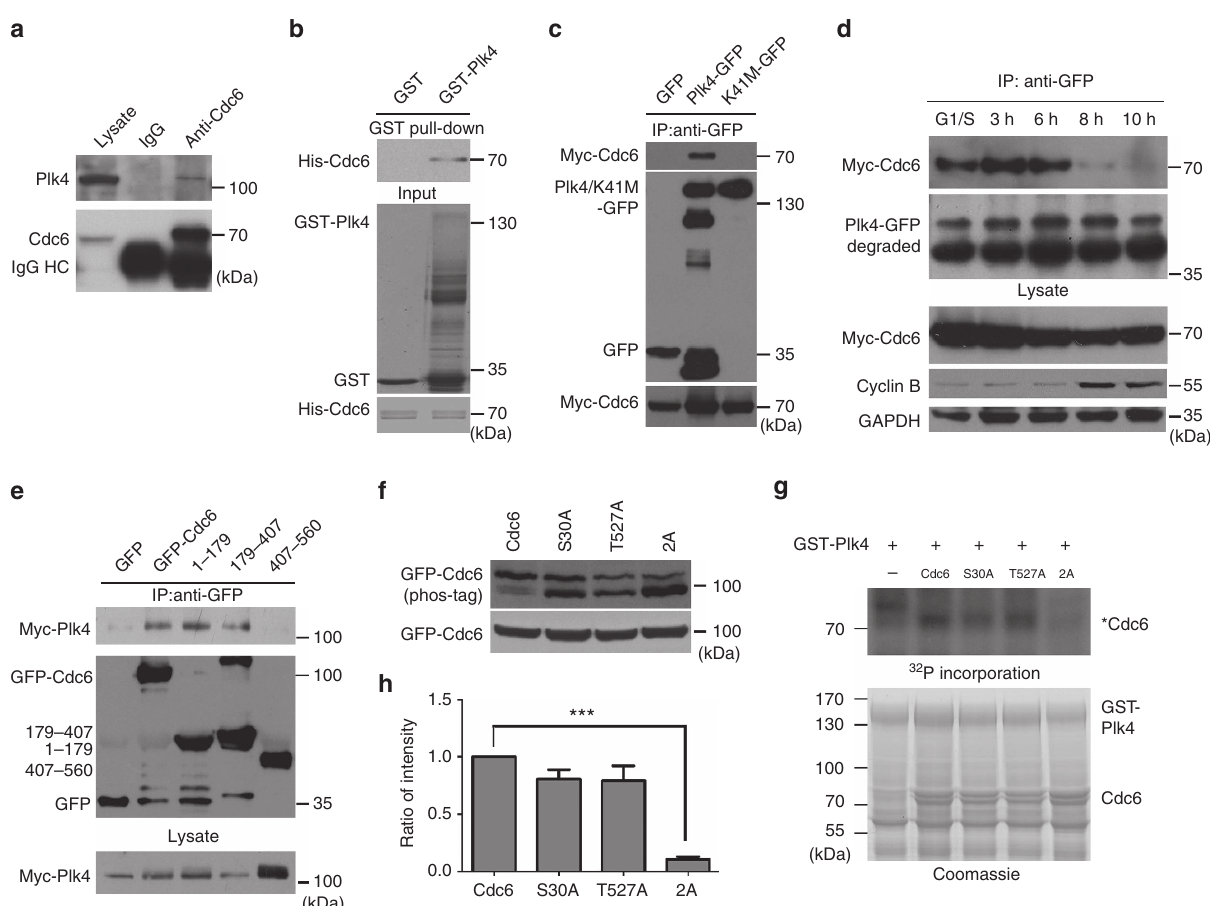
Figure 4 | Plk4 binds Cdc6 in S phase and phosphorylates Cdc6. ( a ) Endogenous Cdc6 interacts with Plk4 in cells. HEK293 total cell extract was immunoprecipitated with a Cdc6 antibody, and probed with Cdc6 and Plk4 antibodies. ( b ) Plk4 directly binds Cdc6 in vitro . Sepharose beads coupled with purified GST or GST-Plk4 were incubated with purified His-Cdc6 and analysed using His antibody. The loadings of indicated proteins are shown by Coomassie blue staining. ( c ) The Plk4 kinase-dead mutant K41M does not bind Cdc6 in cells. HEK293 cells were co-transfected with Myc-Cdc6 and GFP- Plk4 WT or K41M mutant. Total cell extracts were immunoprecipitated with GFP antibody, and probed with Myc and GFP antibodies. ( d ) Cdc6 interacts with Plk4 during S phase. HEK293 cells were co-transfected with GFP-Plk4 and Myc-Cdc6 and synchronized at the G1/S transition. The cells were then released for the indicated time period, collected for immunoprecipitation using GFP antibody, and analysed by western blotting using Myc, GFP, cyclin B and GAPDH antibodies. ( e ) N-terminus of Cdc6, but not C-terminus of Cdc6, interacts with Plk4. GFP, GFP-tagged Cdc6 WT or Cdc6 truncate was immunoprecipitated with GFP antibody from total cell extract of HEK293 cells co-transfected with Myc-Plk4. Immunoprecipitated proteins were analysed using Myc and GFP antibodies. ( f ) Cdc6 is phosphorylated on S30 and T527 in cells. HEK293 cells were transfected with GFP-tagged Cdc6 or Cdc6 mutants, and the cell lysates were probed with GFP antibody using Phos-Tag acrylamide assay (upper panel). ( g ) Plk4 phosphorylates Cdc6 on S30 and T527 in vitro . Purified GST-Plk4 was incubated with purified His-tagged Cdc6 or Cdc6 mutant proteins in the presence of [ g - 32 P]-ATP, followed by autoradiography. Coomassie blue staining shows the loading of indicated proteins. Asterisk indicates the phosphorylated Cdc6. ( h ) Quantitation of ( g ) for Cdc6 WT, S30A, T527A or 2A phosphorylation from four independent experiments. The relative intensity of the phosphorylation signal of each protein was normalized to its protein level by ImageJ. The phosphorylation signal intensity of Cdc6 WTwas arbitrarily set at an intensity of 1.0. The statistical data in h is presented as means ± s.d. *** P o 0.001 (Student’s t